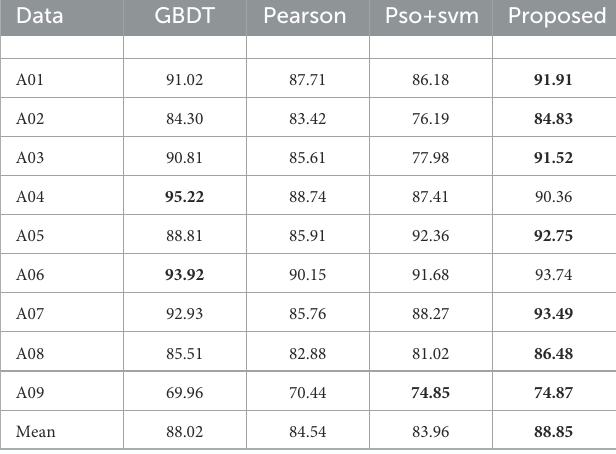
TABLE 6 The classification accuracy different feature extraction algorithms. Data